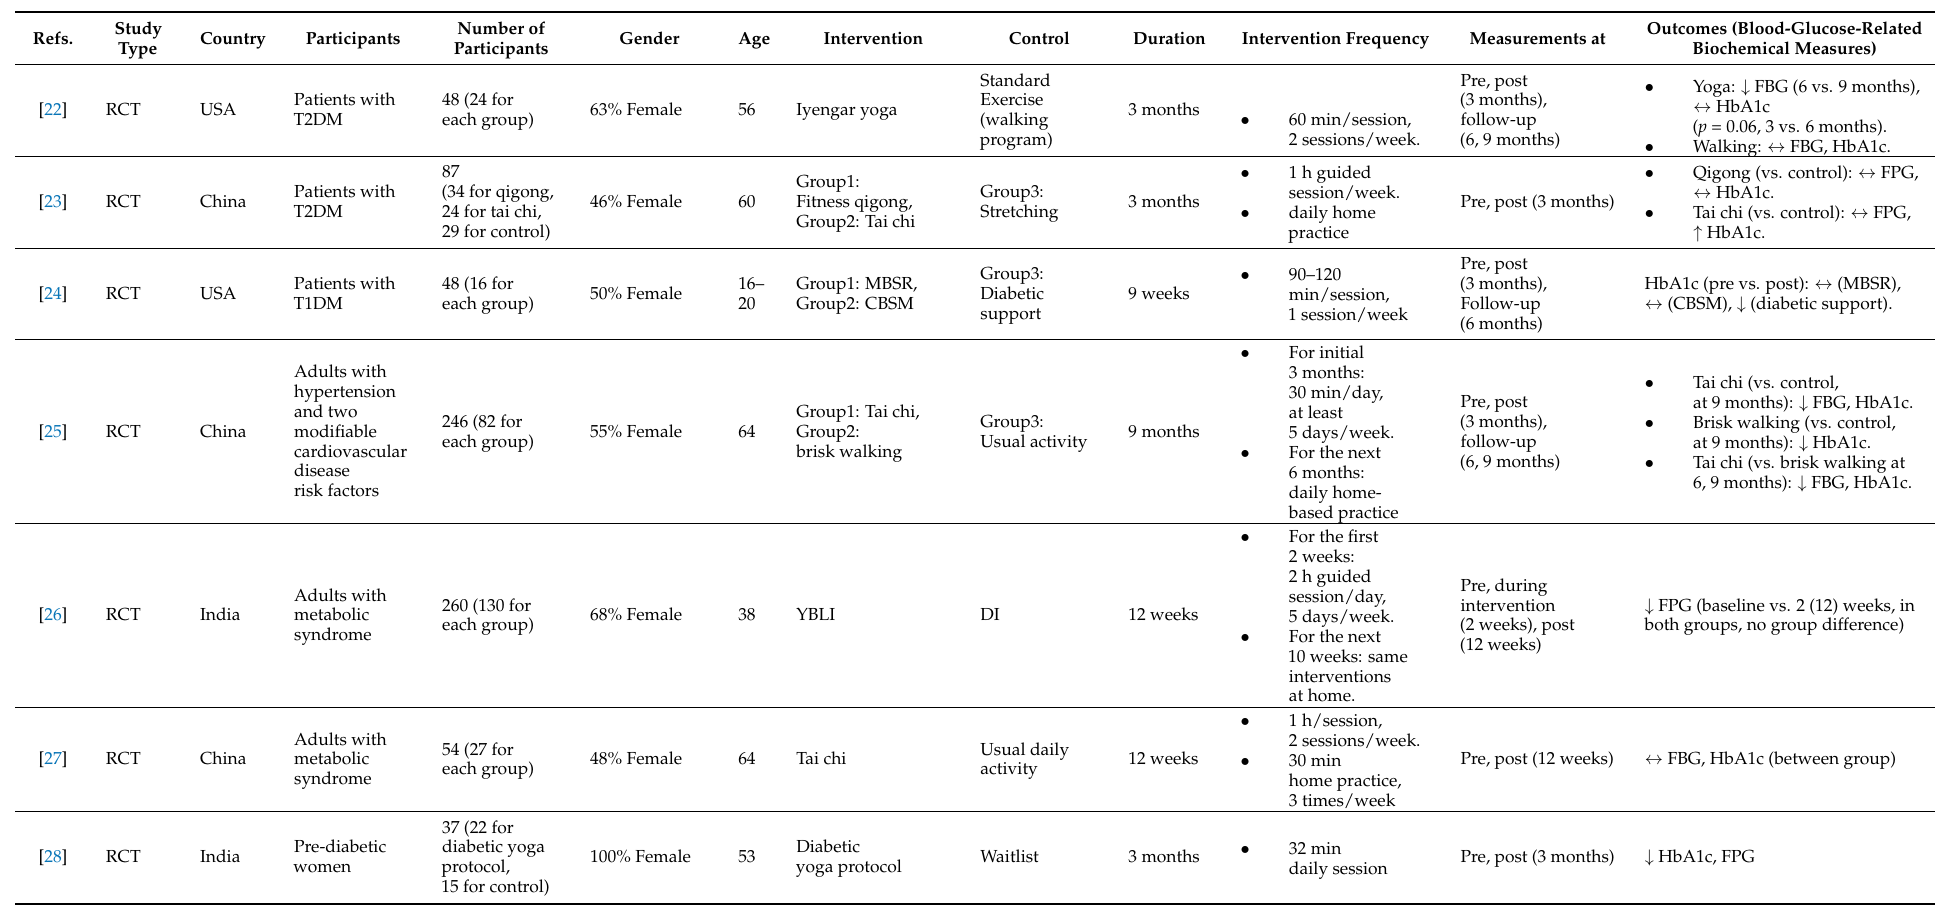
Table 1. The effects of Mind–Body Intervention on blood-glucose-related biochemical measures. Randomized controlled trials over the last 5 years regarding the effects of Mind–Body Intervention on blood-glucose-related biochemical measures are summarized.